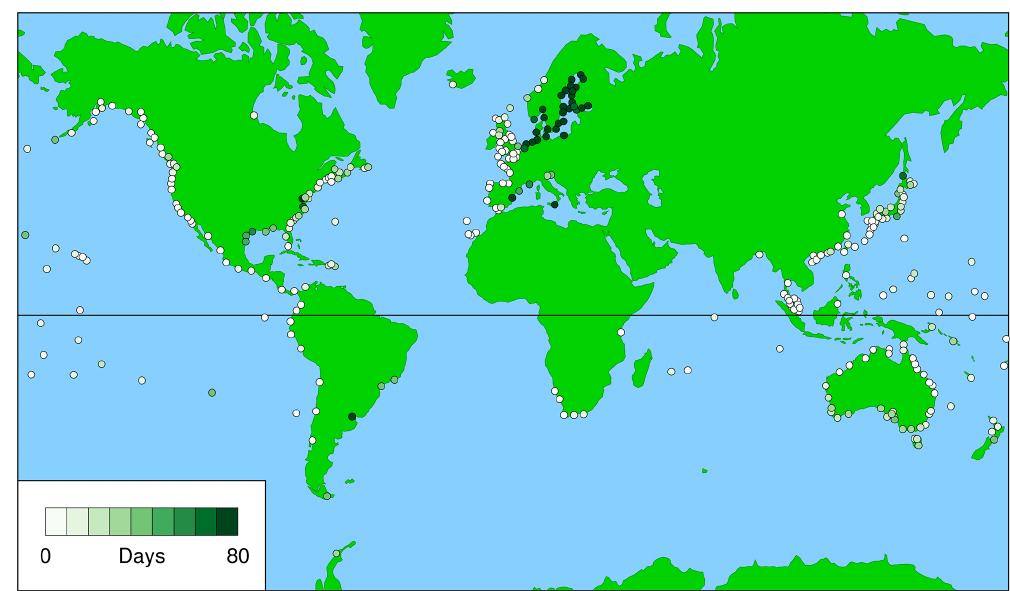
Figure 3. Averaged second metric , which is no. of days when observed sea level, o c (i,j,k) , higher than observed maximum on day of highest predicted tide for the year, o c (I pc (j,k),j,k) , for civil days , averaged over all valid years, j .